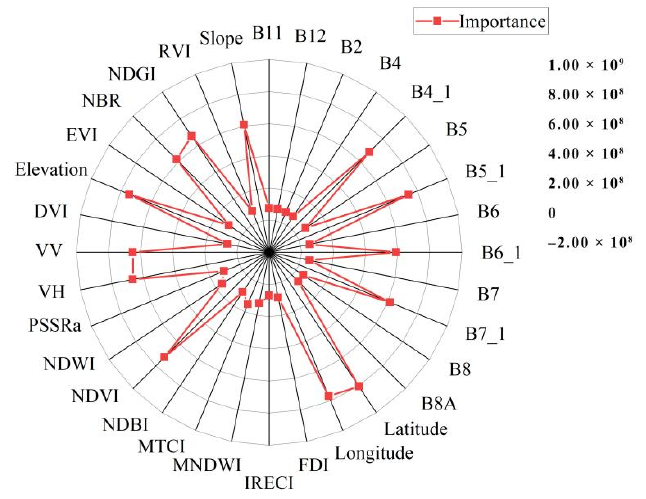
Figure 5. Feature importance ranking.